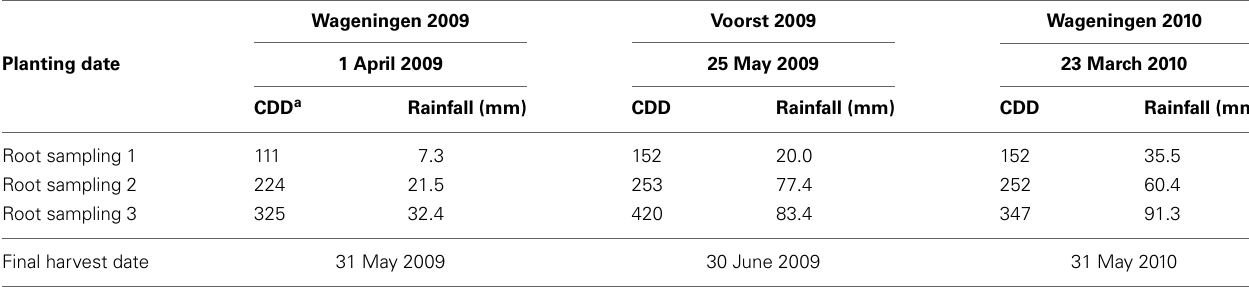
Table 1 | Planting and harvesting dates and cumulated thermal time (CDD) and rainfall at the three sampling moments for each of the three field